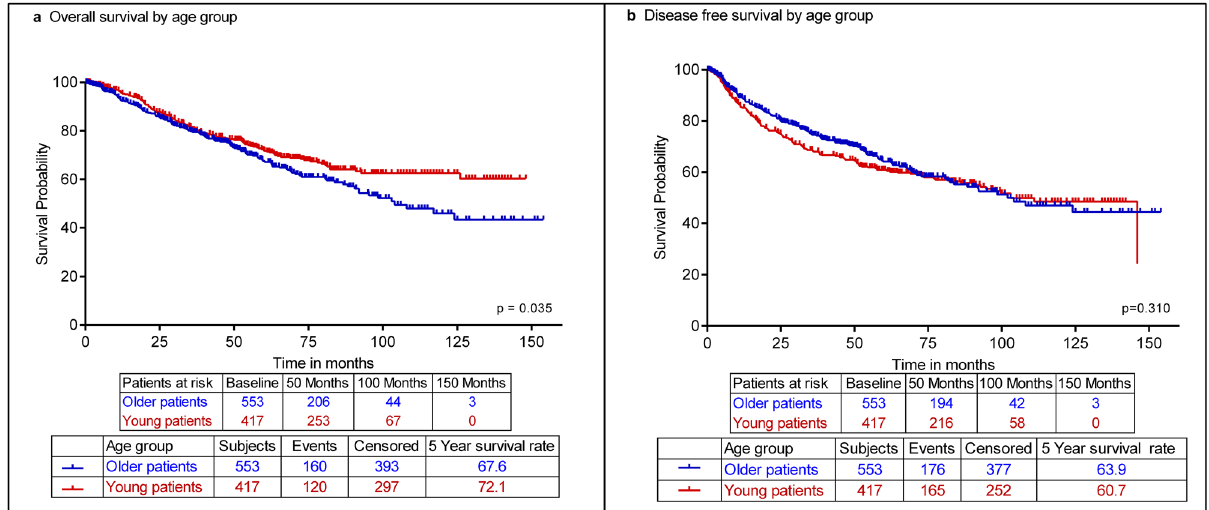
Figure 3. Overall and disease-free survival of older and young breast cancer patients. ( a ) Kaplan–Meier plot showing significant difference in overall survival by age group, log-rank p = .035. ( b ) Kaplan–Meier plot showing none-significant difference in disease-free survival by age group, log-rank p =